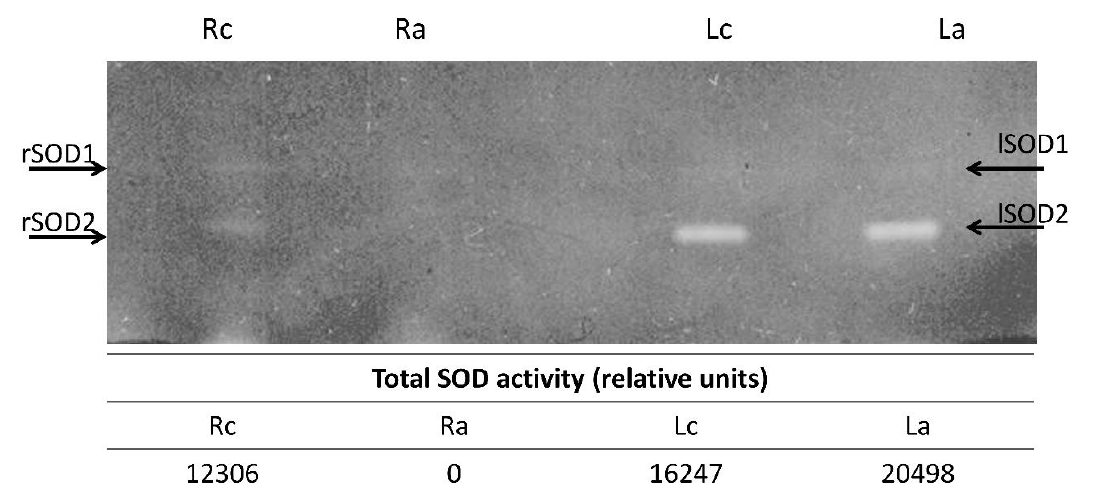
Figure 5. SOD activity was determined using 10% native gel in roots and leaves of control and ash- growing plants. SOD activity, obtained by densitometry after analysis of gels in the program TotaLab, was presented in the table below the gel. The arrows indicate the different SOD isoforms: rSOD1 and rSOD2 in root samples and lSOD1 and lSOD2 in leaf